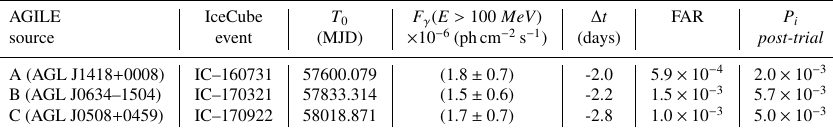
Table 1. The three AGILE QL detections close in time and space to IceCube HESE / EHE neutrinos. Column 1 displays the AGILE name assigned to the transient. Columns 2 and 3 show the main parameters of the corresponding IceCube event (event ID, neutrino event time T 0 ). Columns 4 to 6 show, respectively, the AGILE γ -ray flux (above 100 MeV) estimated over the QL 2-day integration time bin, the distance in time ∆ t from the QL detection centroid and T 0 , the false alarm rate (FAR) expected for each detection, and the corresponding post-trial false alarm probability P i . AGILE